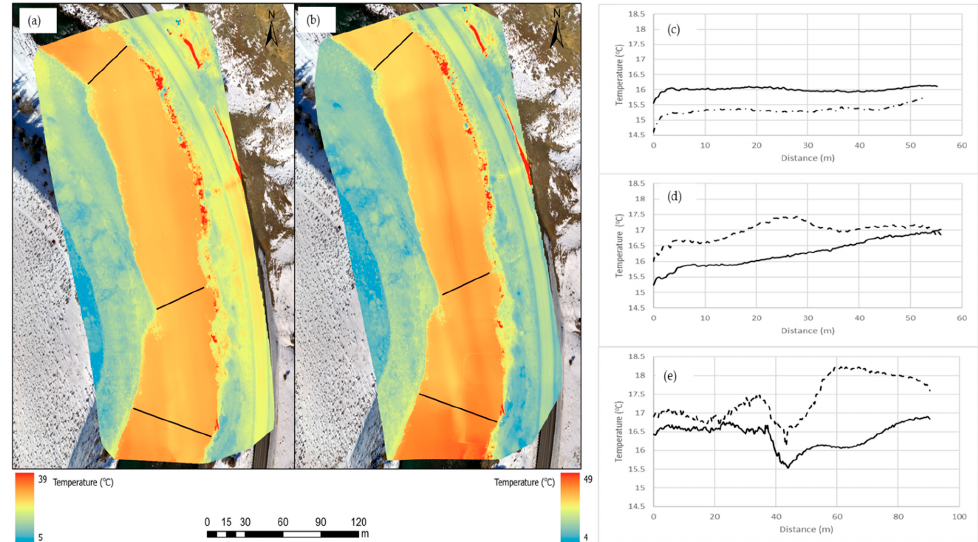
Figure 9. Back-to-back flights thermal imagery ( a , b ) to assess the collocated temperature variation. River flow direction is from south to north. Black lines represent the temperature cross sections. Temperature profiles on the right from top to bottom are the northern most ( c ), middle ( d ) and south ( e ) cross sections, respectively. The dashed and solid lines are east-to-west and west-to-east flights, respectively. Temperature cross sections run from the west to east bank of the river.